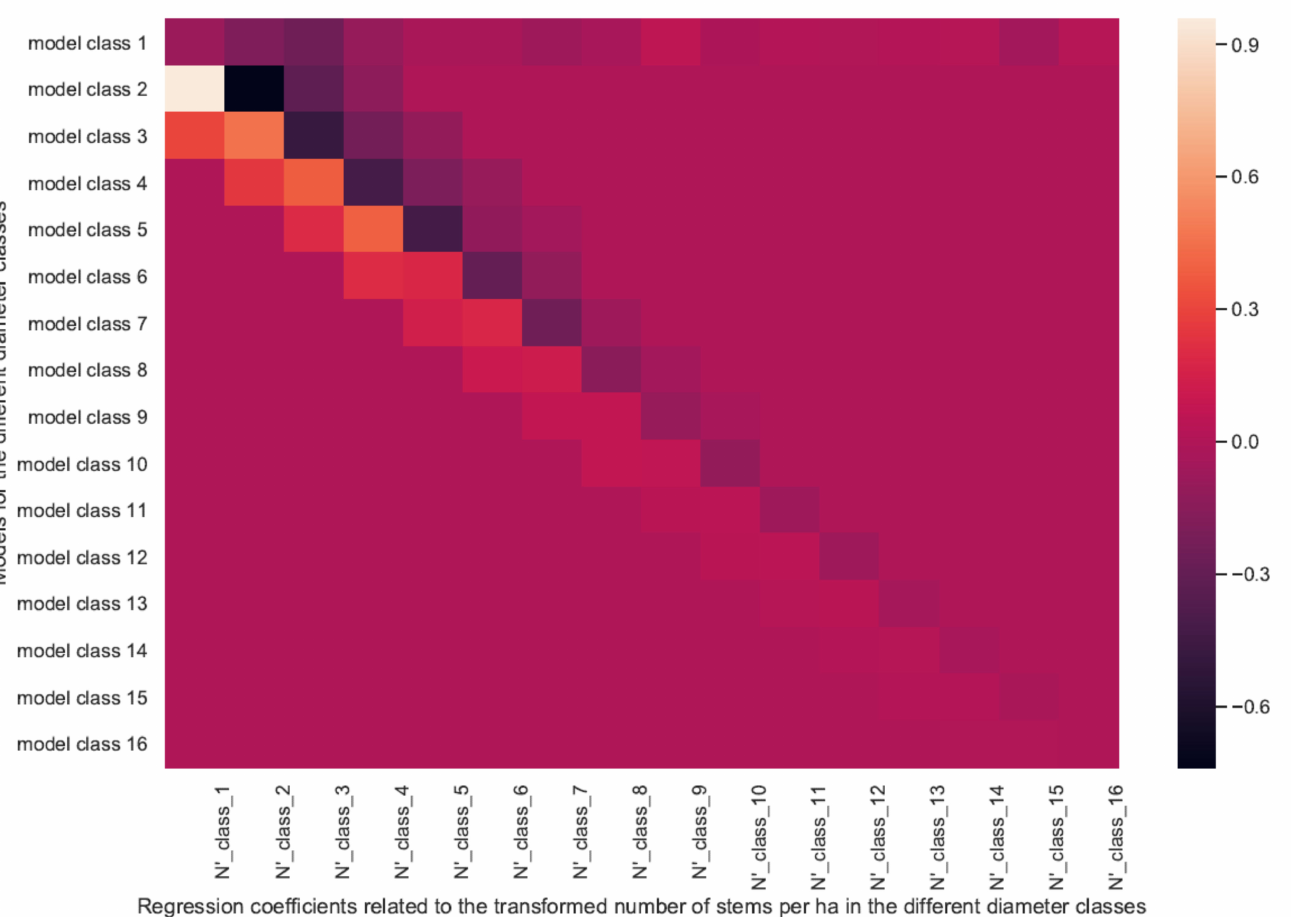
Figure 3. Heatmap of the regression coefficients for the models given by Equation (7) (the values are given in Table A3 in Appendix